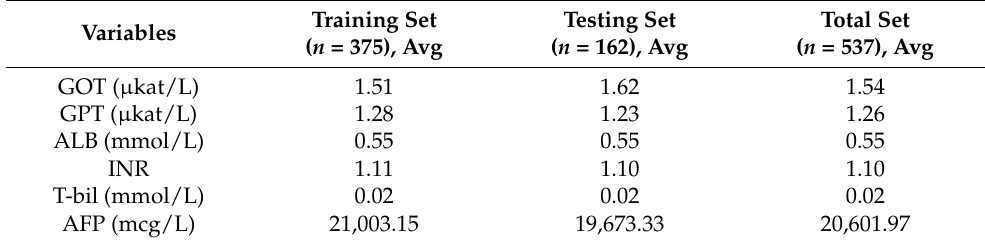
Table 2. The Distribution of Continuous Data.